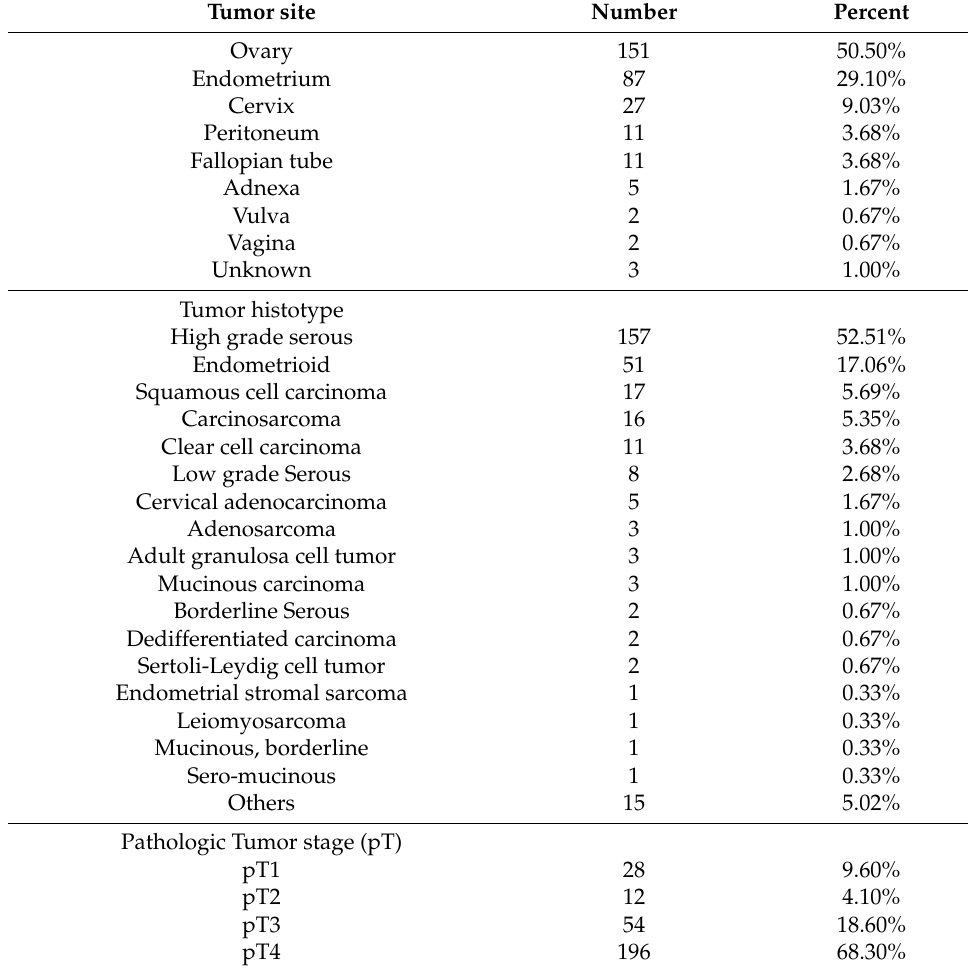
Table 1. Histopathologic characteristics of the cases tested by